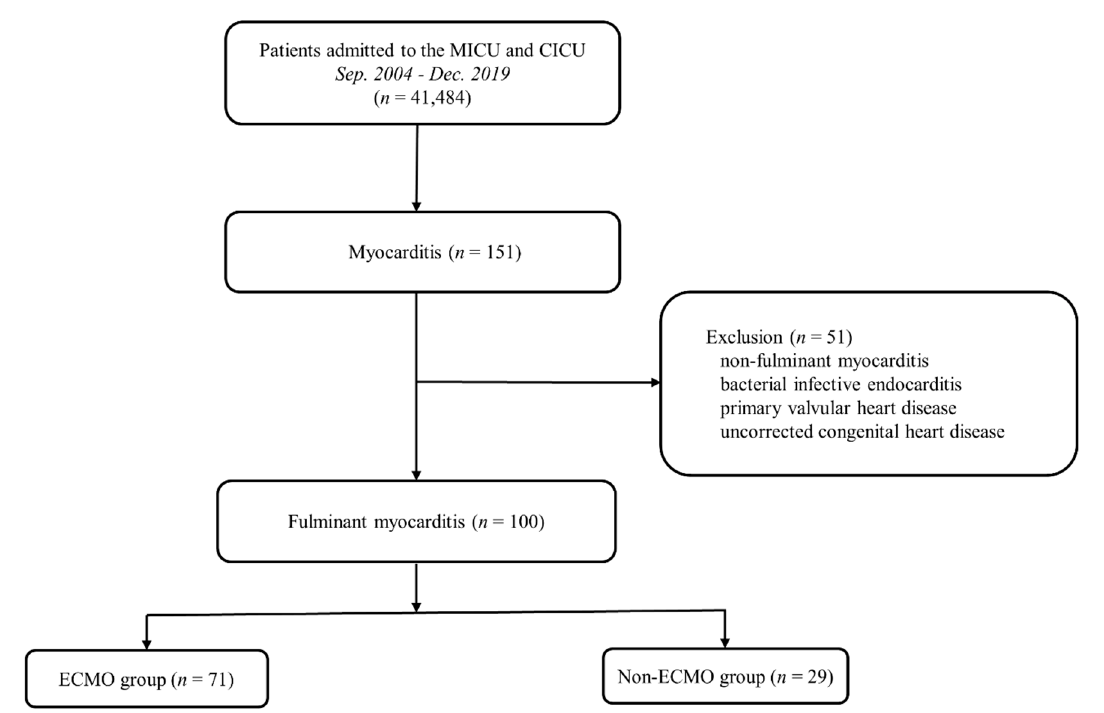
Figure 1. Study flowchart. CICU: cardiac intensive care unit; ECMO: extracorporeal membrane oxygenation; MICU: medical intensive care unit.